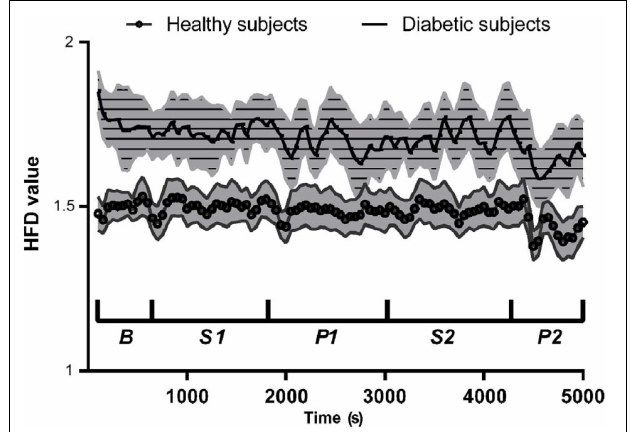
FIGURE 2 | Mean ± 95% confidence intervals of HFD values during the course of experiment, for healthy and diabetic subjects separately.